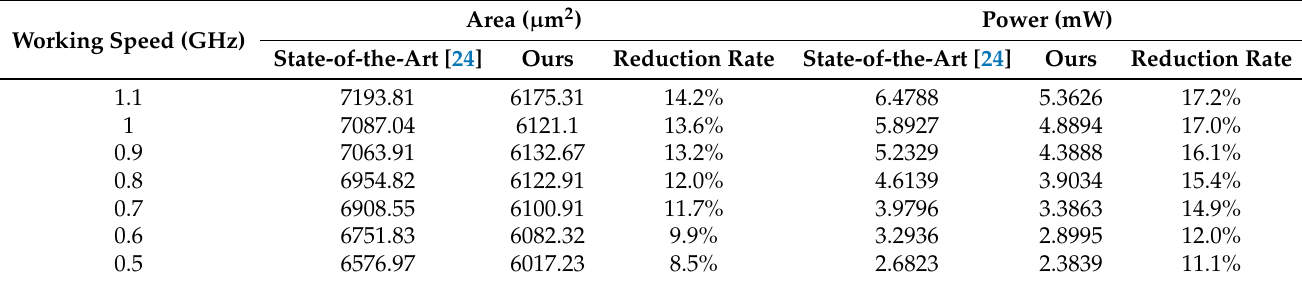
Table 7. Comparisons on different 2 × 2 CA-O